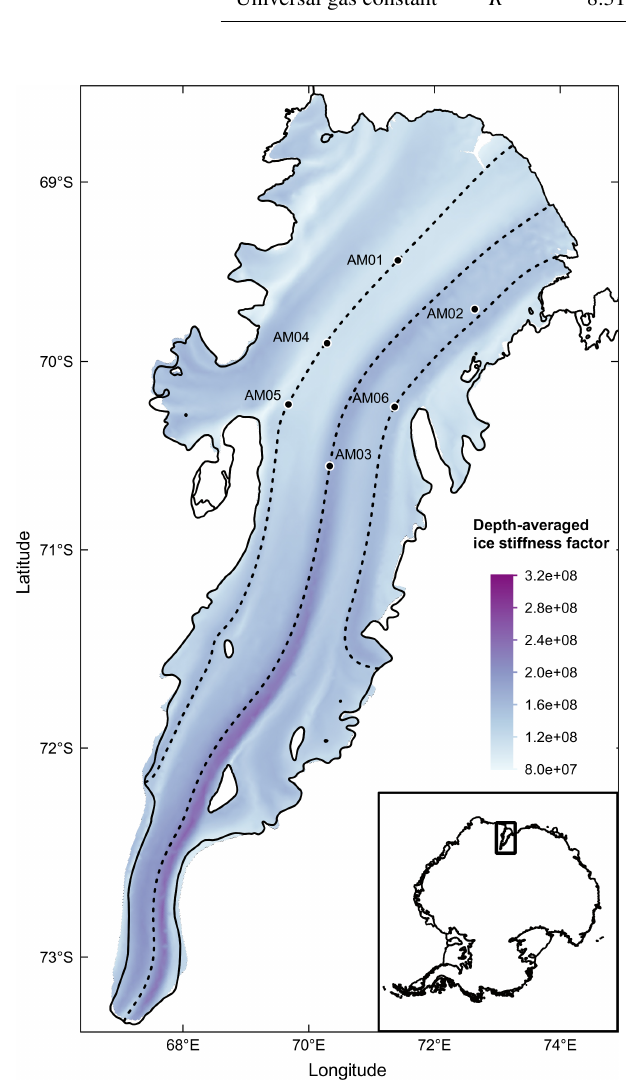
Figure B1. Depth-averaged temperature-dependent ice stiffness factor B(T (cid:48) ) (in Pas 1 / 3 ) of the AIS derived from the simulated temperature field. Three flowlines, derived from simulated velocity field, are shown with dashed lines. The six boreholes are marked, and the inset shows the location of the Amery Ice Shelf in East